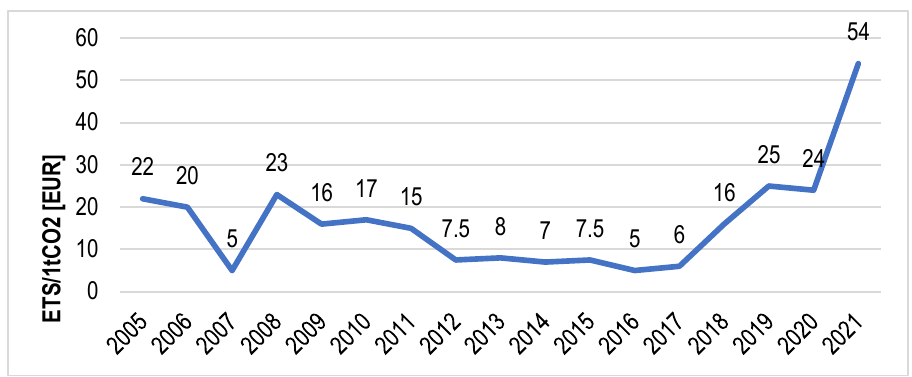
Figure 1. Average EU ETS price in 2005 – 2021. Source: own study based on historical data [13] .